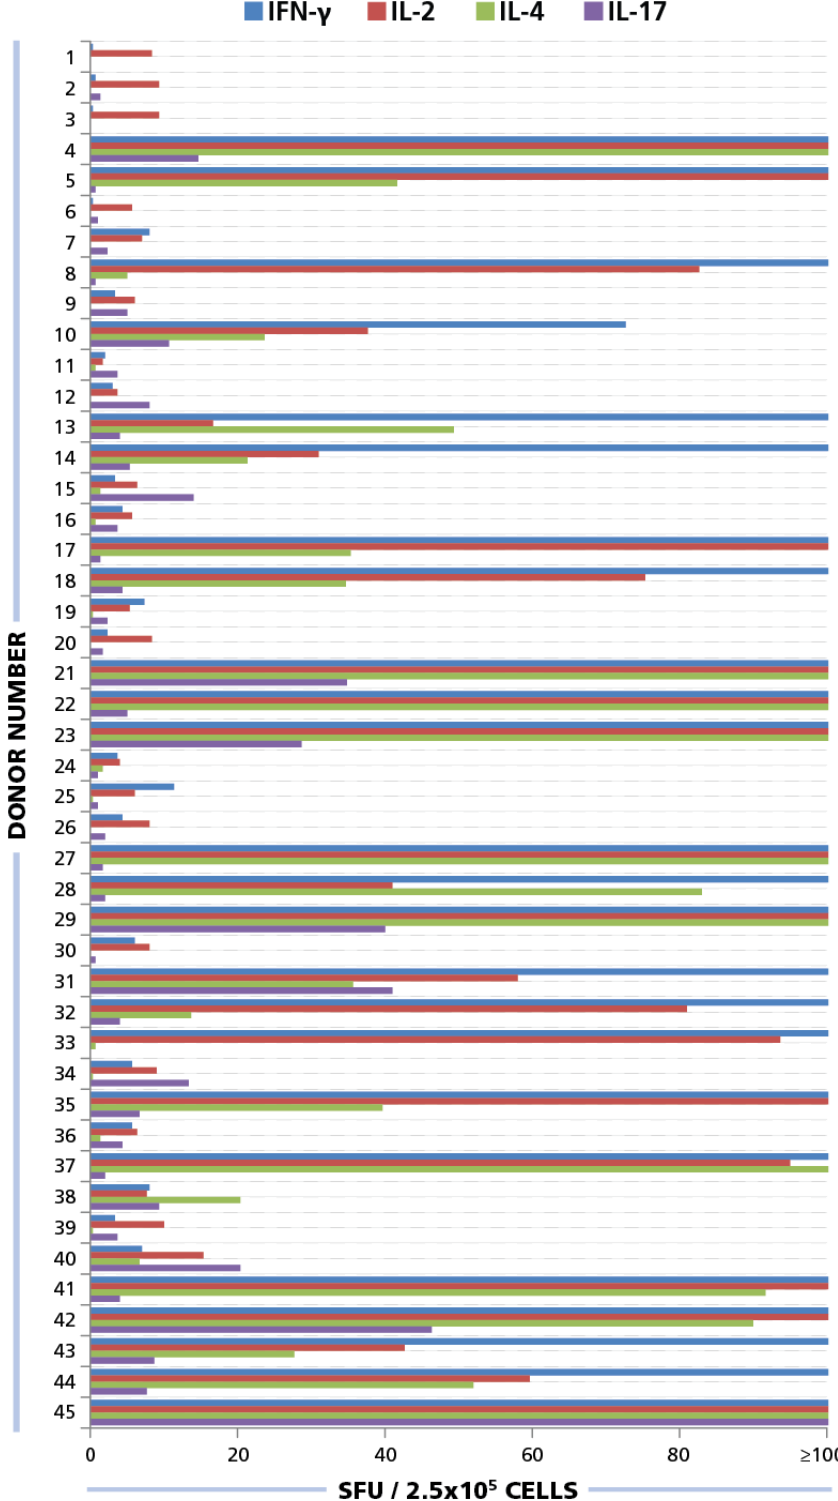
Figure 4. ELISPOT responses for IFN-γ, IL-2, IL-4, and IL-17. PBMC from 45 donors were plated at 250,000 cells/well and 50 μg/mL of HCMV antigen was added to induce a recall response for INF-γ (blue bars), IL-2 (red bars), IL-4 (green bars), and IL-17 (purple bars) from CD4 cells. SFU for each cytokine was established. SFU greater than 100 spots per well are not shown here. Raw data is available as part of Table S1.